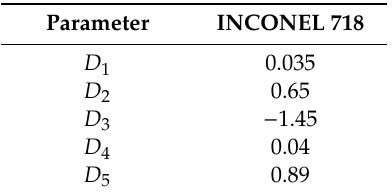
Table 3. JC failure parameters for Inconel 718.